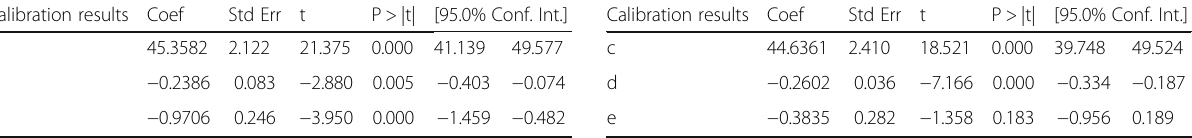
Table 3 Calibration results of linear function model Eq.(2) for cities with population densities above 1500 per sq. km. R 2 = 0.269, sample size N = 88 Calibration results Coef Std Err t P > |t| [95.0% Conf.